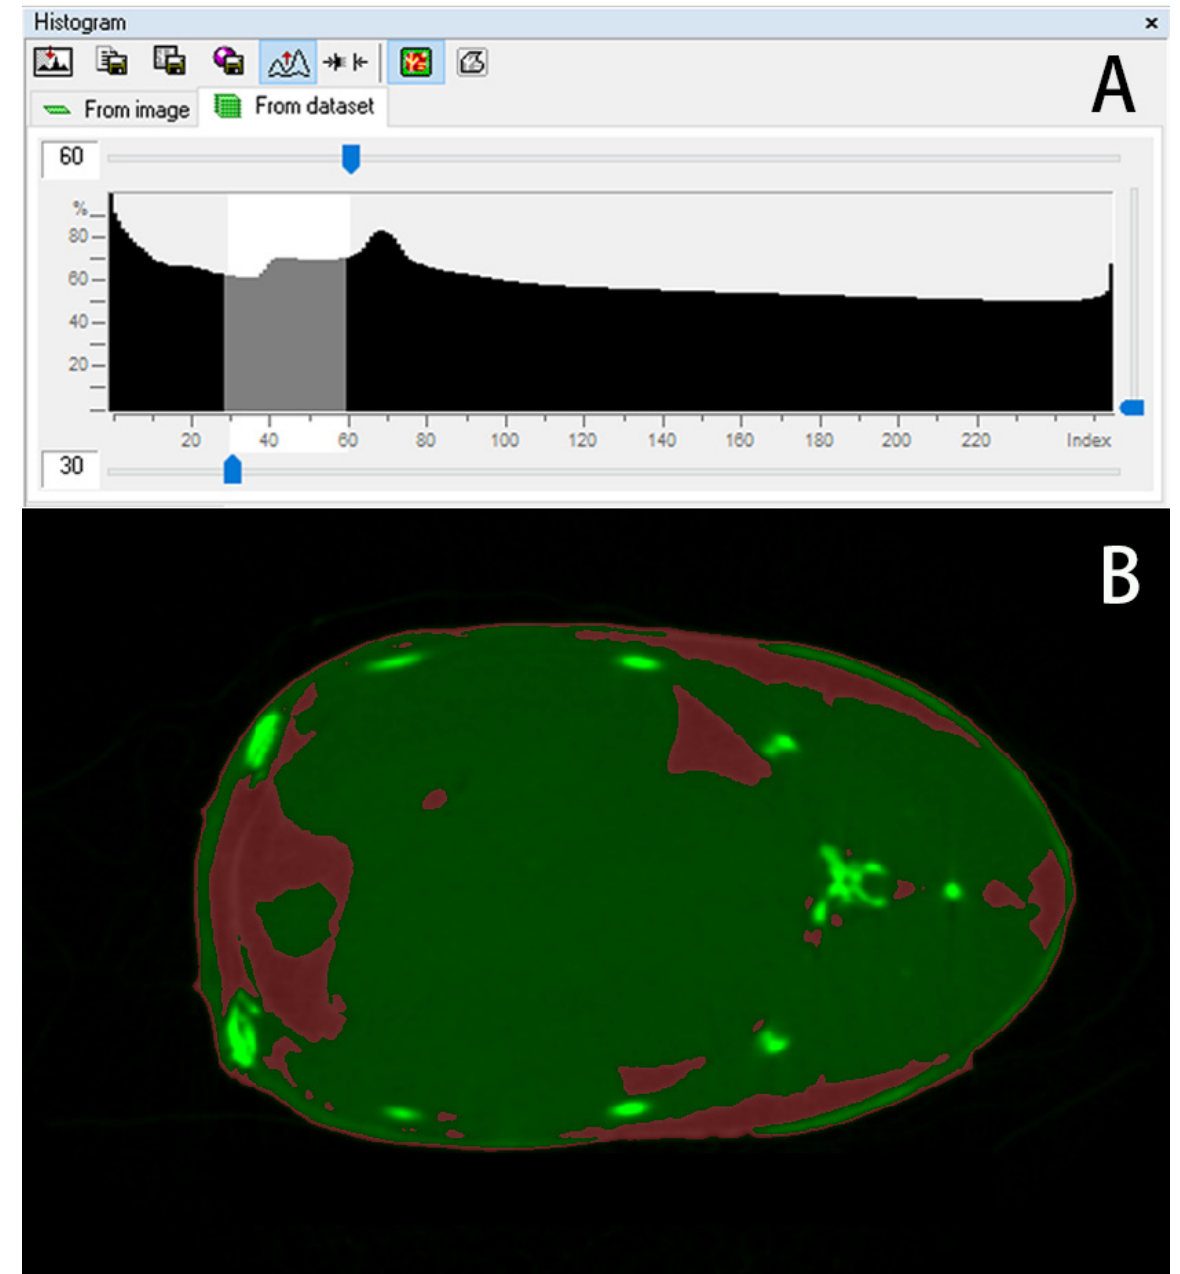
Figure 4. Upper and lower limits of the threshold range ( A ) and preview of the selected red area ( B ).